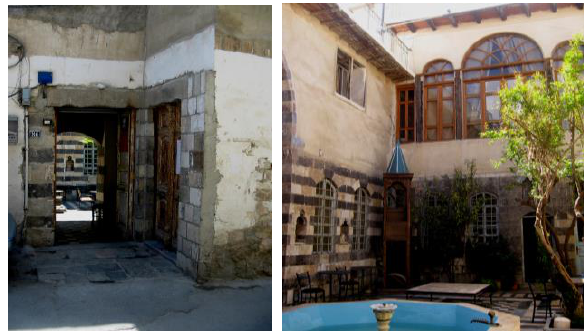
Figure 5. Studio of the artist Mustafa Ali, R.Aboukhater, April